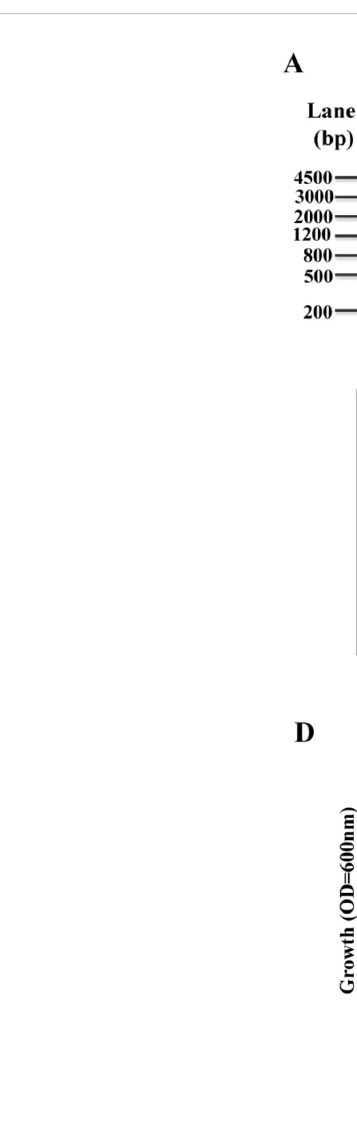
FIGURE 1 Construction of D capC strain and the colony morphology and growth of wild-type and D capC strains. (A) PCR veri fi ed the deletion of the capC gene. M: DNA Maker III; 1: capC -LF/LR, 1 835 bp; 2: D capC -LF/LR, 1 106 bp; 3: capC -LF/SR, 1 396 bp; 4: D capC -LF/SR, 667 bp; 5: capC -SF/LR, 1 600bp; 6: D capC -SF/ LR, 871 bp; 7: capC -SF/SR, 1 161 bp; 8: capC -SF/SR, 435bp. The orf (open reading frame) length of capC is 729 bp. (B, C) Bacterial colony characteristics of experimental strains. (D) Growth curve of experimental strains at 25°C. The * indicates a signi fi cance level of p < 0.05. The same as